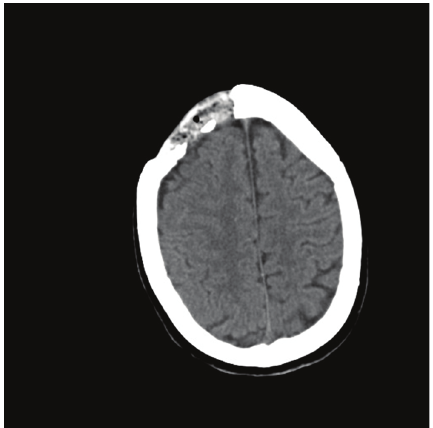
Figure 1: Pelvic/abdominal X-ray showing osteopenia. Figure 2: Head CT showing encephalomalacia in the right frontal lobe.